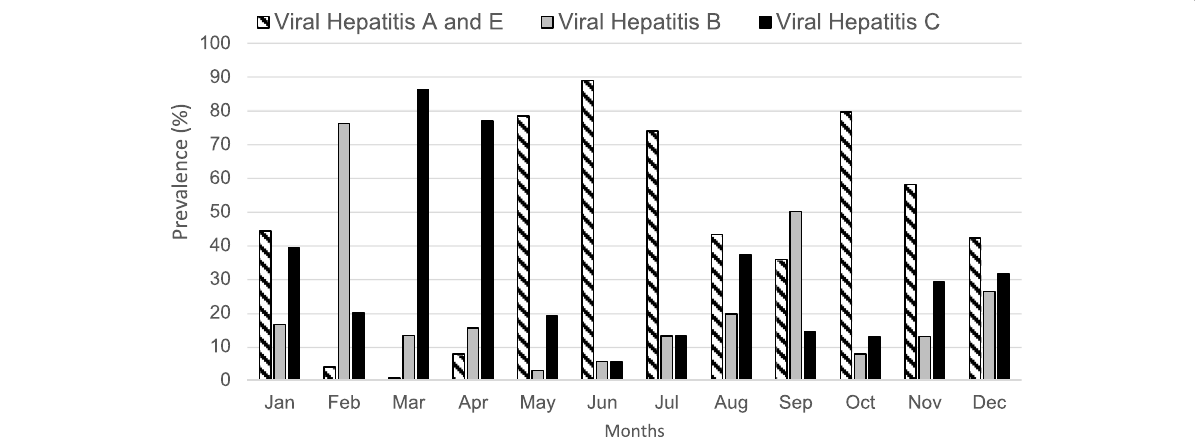
Fig. 1 Monthly comparative percentage prevalence of different types of viral hepatitis in the District Dera Ismail Khan, Khyber Pakhtunkhwa in 2020